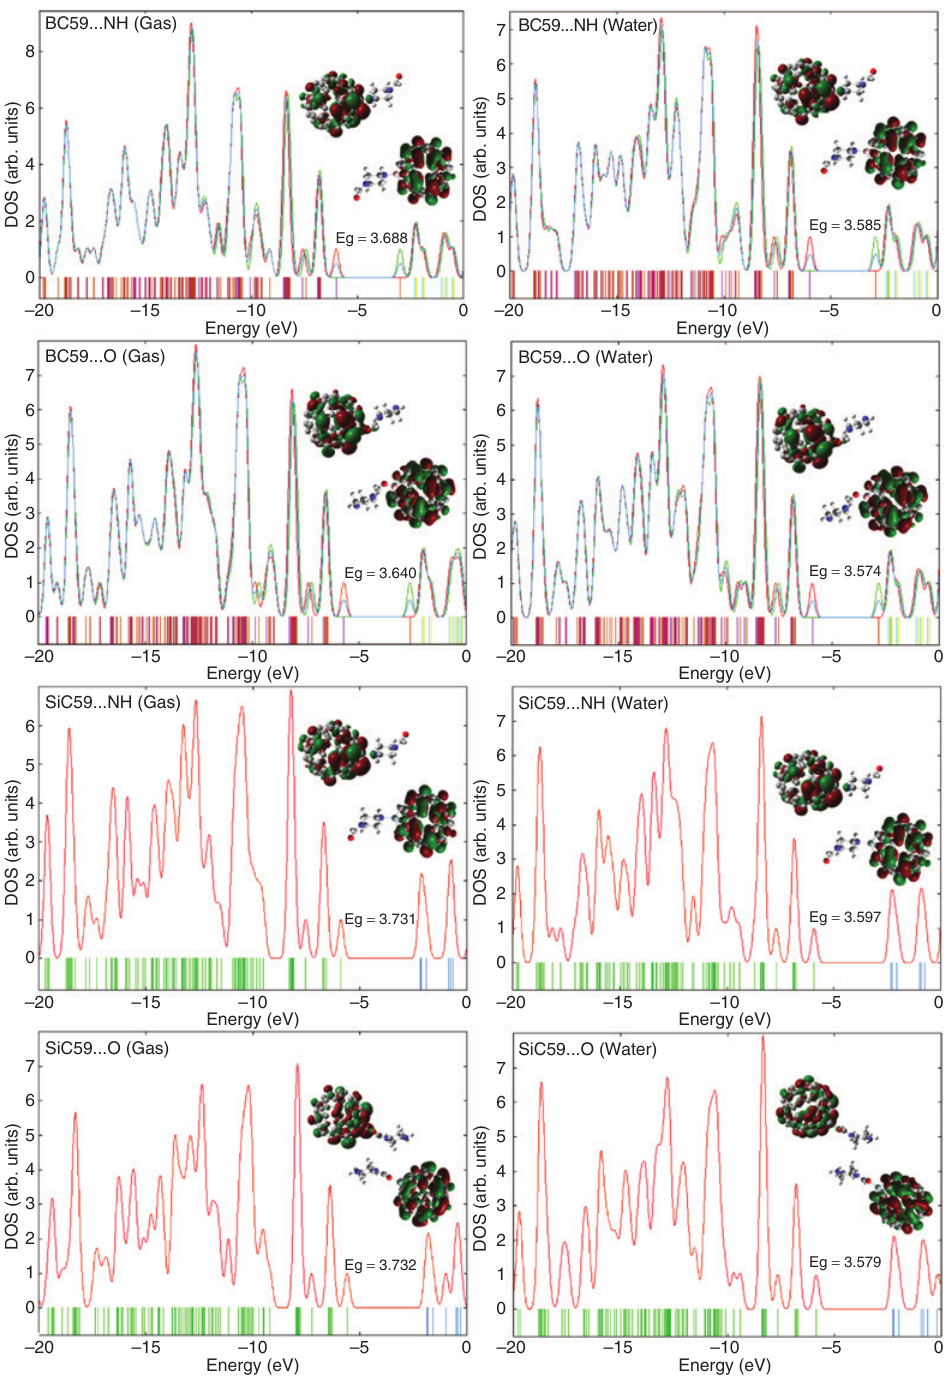
Figure 3: DOS spectra of the investigated structures by M062X/6-31G(d).